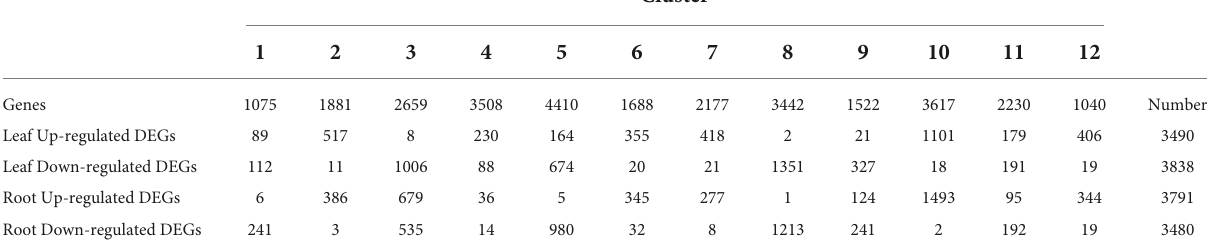
TABLE 1 Distribution of DEGs among different